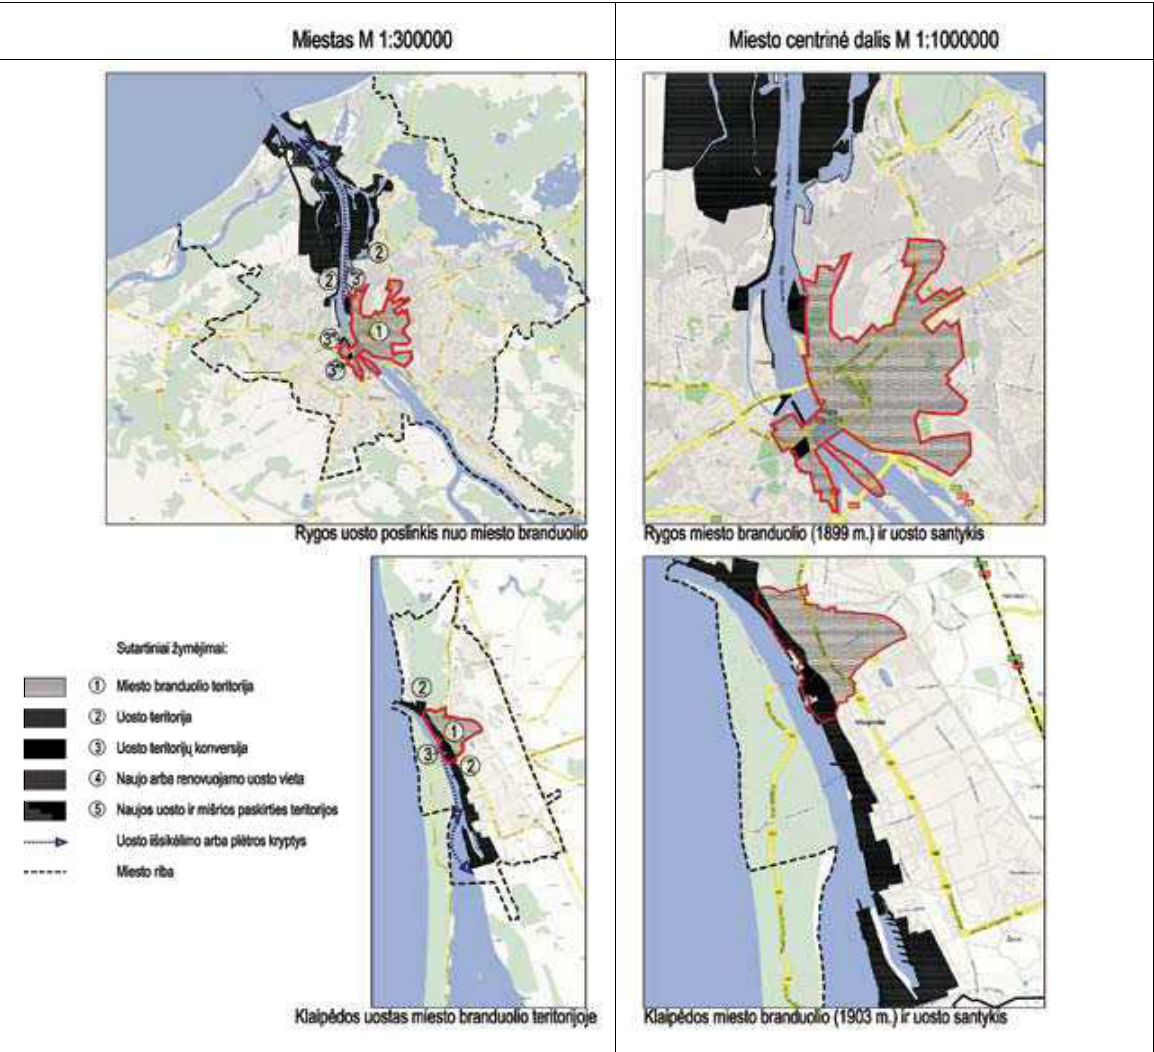
Table 3. Urban dynamics of the baltic seaports